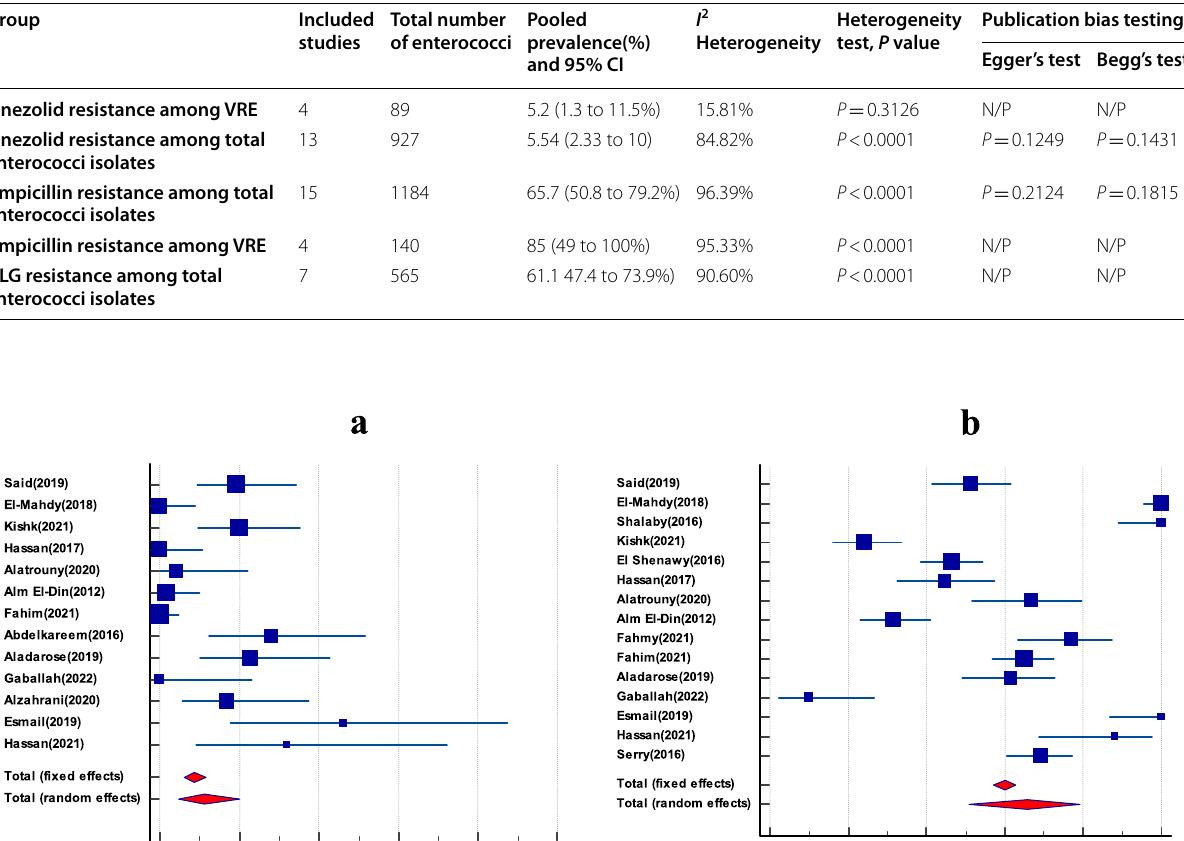
Table 3 Pooled resistance profile of enterococci isolates in Egypt